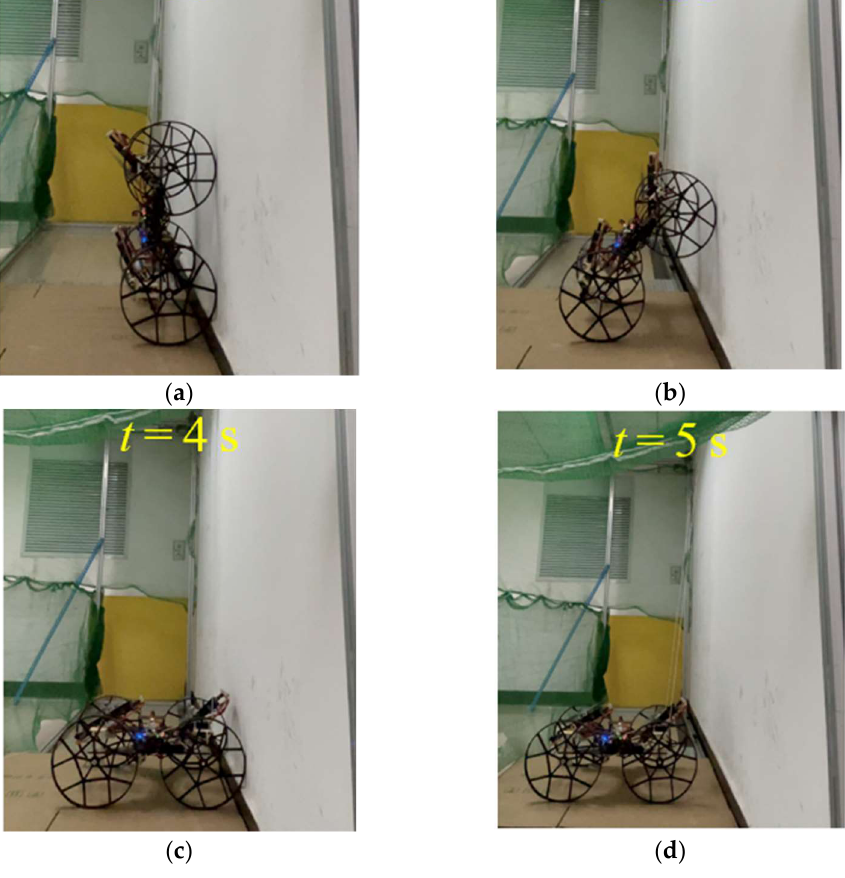
Figure 14. Wall-ground transition experiment of DP-Climb: ( a ) preparation for going down the wall; ( b ) the drive wheels reversed, and the robot went down the wall; ( c ) the robot finished going down the wall; ( d ) the robot walked on the ground.